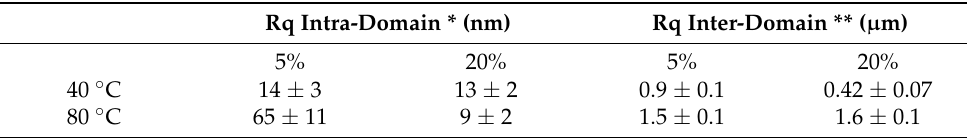
Table 1. Root-mean-square height of the surface in terms of intra-/interspherulitic